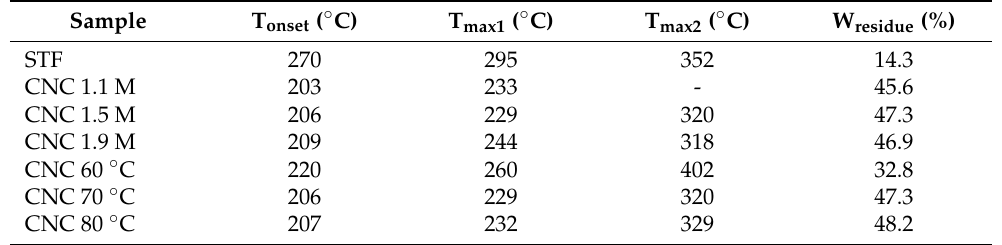
Table 3. Thermal properties of STFs and CNCs prepared under different APS concentrations at 70 ◦ C for 16 h and under different oxidation temperatures with a 1.5 M APS concentration for 16